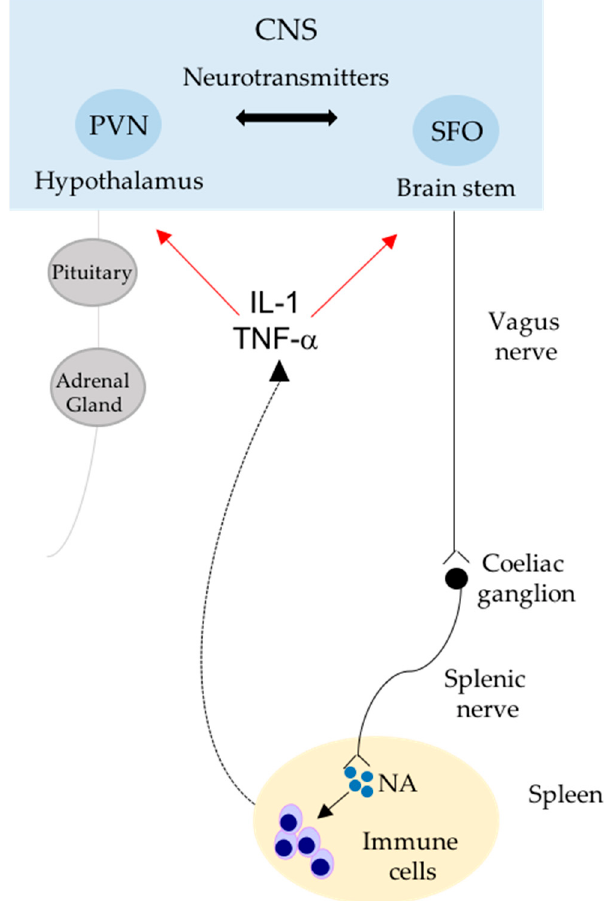
Figure 2. Bi-directional communication between the nervous and immune system. The scheme shows an integrative interface between the sympathetic nervous system (SNS), the hypothalamic-pituitary-adrenal (HPA) axis and the splenic immune reservoir. The SNS modulates immune cell activity through noradrenaline (NA) released in the spleen; and, in turn, the SNS activity is regulated by IL-1 and TNF- α cytokines, produced by splenic immune cells in a feedback loop manner. Paraventricular nucleus (PVN); subfornical organ (SFO); central nervous system (CNS). Double arrow: neuronal projections; red arrow: cytokine influence; black arrow: activation; dotted arrow: production.